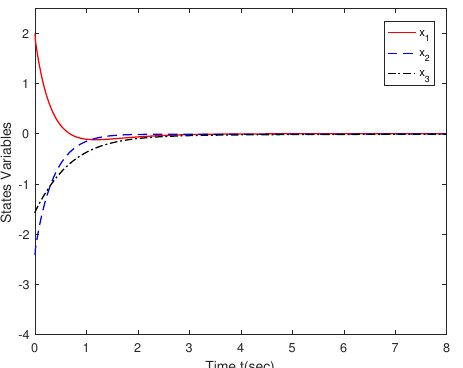
Figure 2. State responses of the integral sliding mode control (SMC).